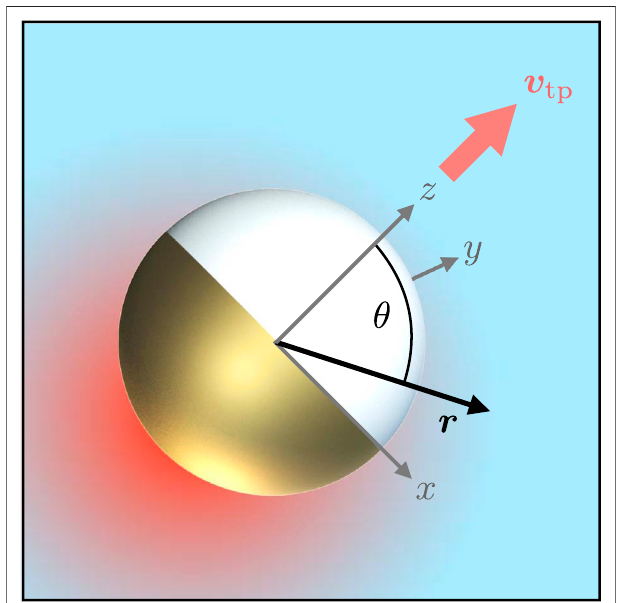
FIGURE 1 | Sketch of a spherical Janus particle coated with a thin gold layer on one hemisphere. Upon heating (indicated by the schematic red color gradient), the particle induces an anisotropic temperature pro fi le in the ambient fl uid. The resulting thermo-osmotic interfacial fl ux gives rise to a netpropulsionatswimspeed v tp alongthesymmetryaxis[20 – 22].Areference frameattachedtotheparticle ’ sgeometriccenterhasits z -axisalignedwiththe symmetry axis, pointing towards the uncoated hemisphere. The polar angle between the position vector r and the z -axis is denoted by θ .